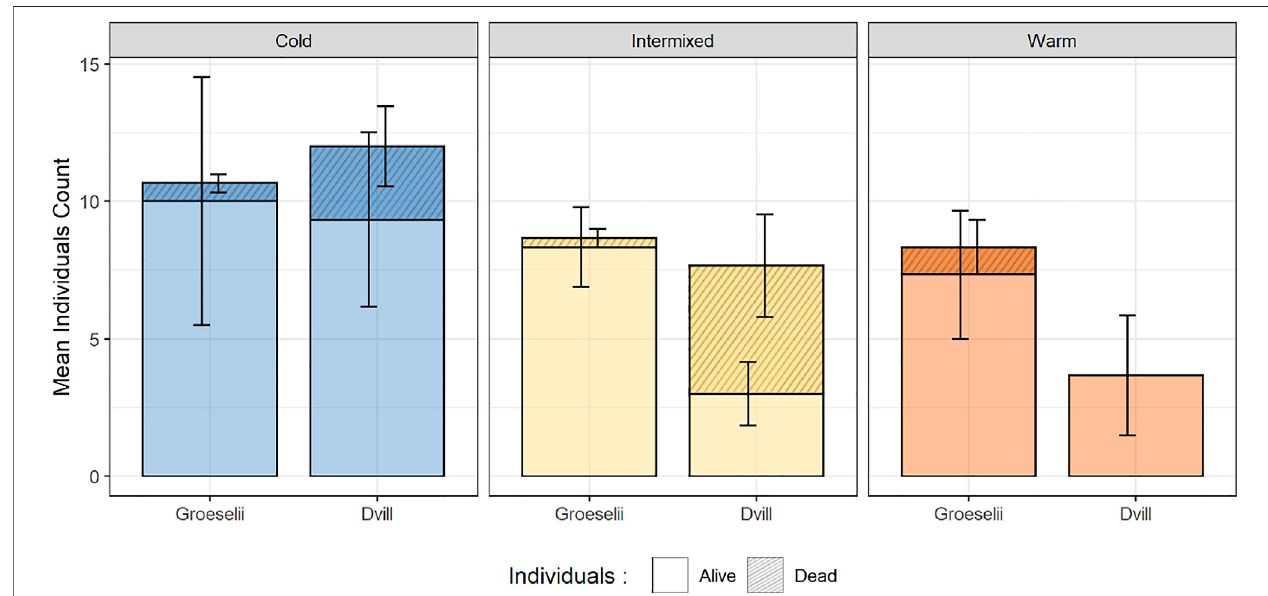
FIGURE 6 | Alive (non-shaded) vs. dead (shaded) of each Groeselii = Gammarus roeselii and Dvill = Dikerogammarus villosus found at the end of the cross- exposure experiment in the exposed compartments of each thermal region.